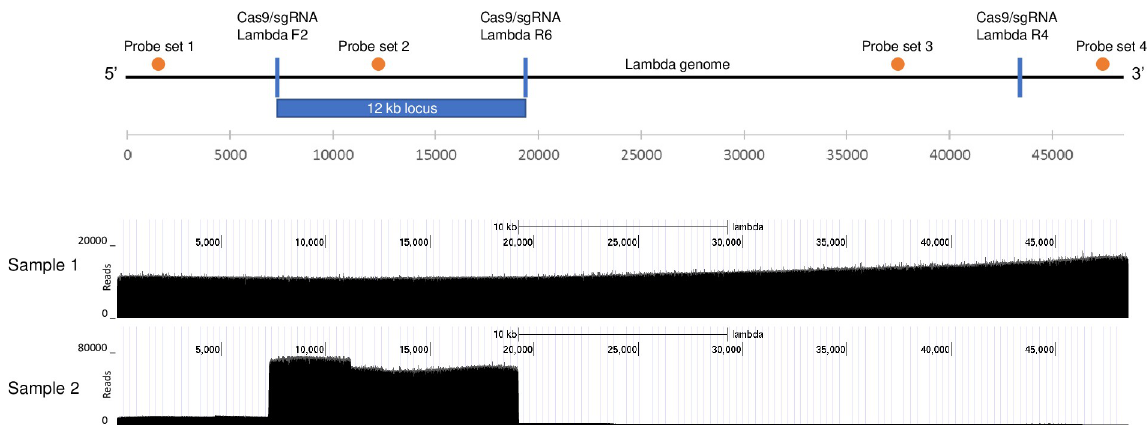
Fig 3. Nanopore analyses demonstrate enrichment of the protected 12 kb lambda DNA region. Plots of aligned Nanopore sequencing results for lambda Negative Enrichment. Sample 1 had lambda DNA without exonuclease. Sample 2 had lambda DNA treated with Lambda F2 and Lambda R6 Cas-RNA complexes and exonucleases III and VII.